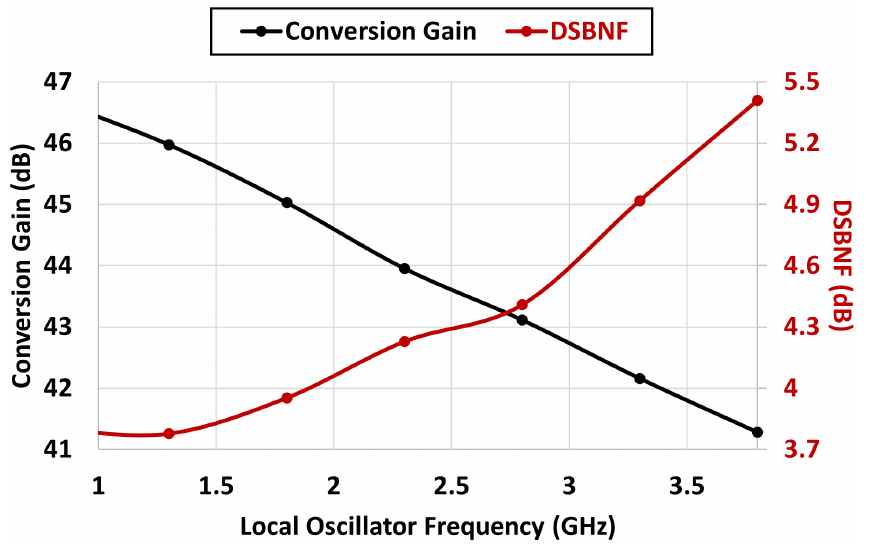
Figure 12. The NF and conversion gain versus the LO